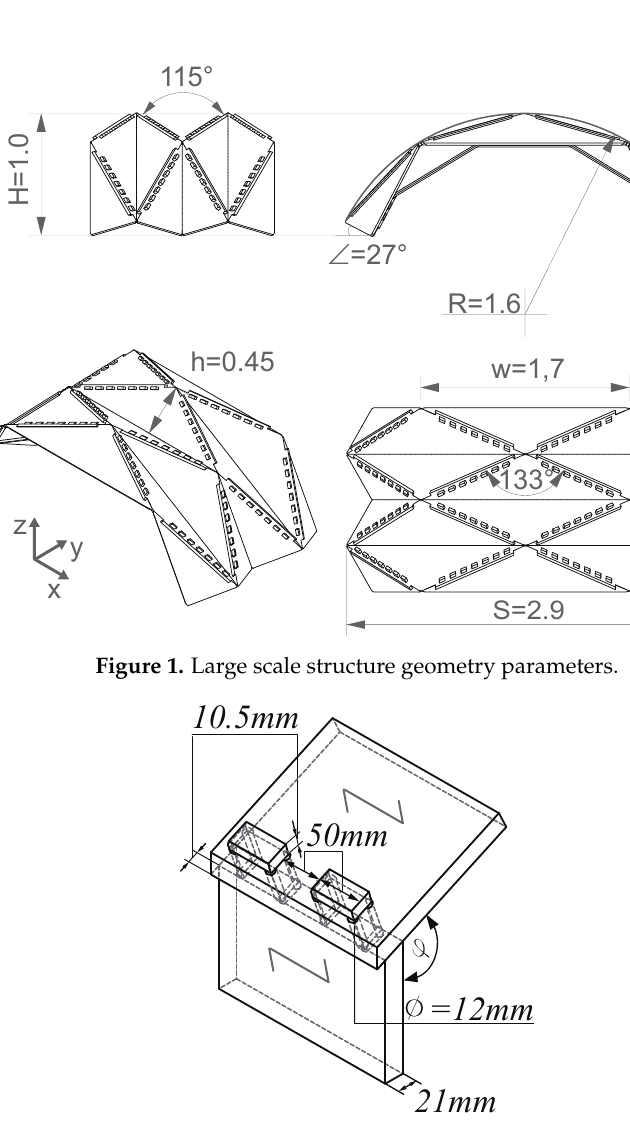
Figure 2. MTSJ closed slot connection details used in large scale structures. The length of both tabs and slots was fixed to 50